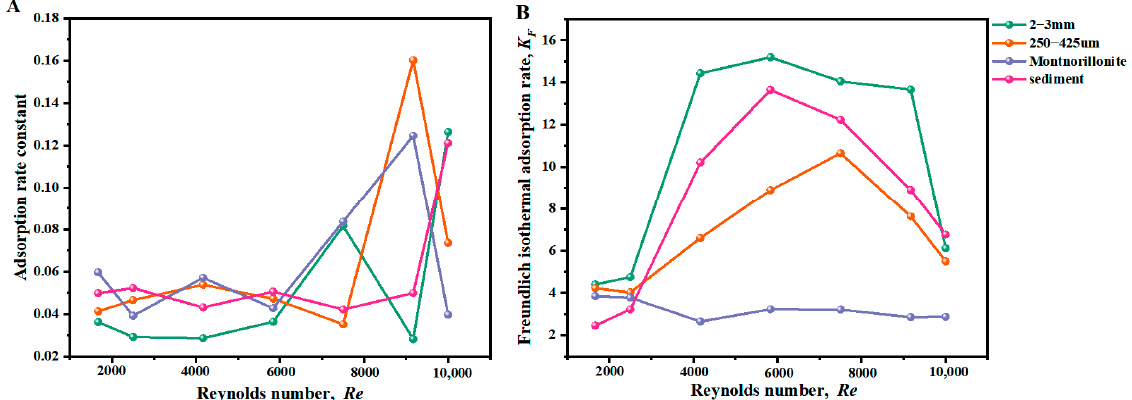
Figure 6. Relationship between Reynolds number and adsorption coe ffi cients, ( A ) adsorption ki– constant and ( B ) Freundlich netic constant and ( B ) Freundlich coe ffi cient.